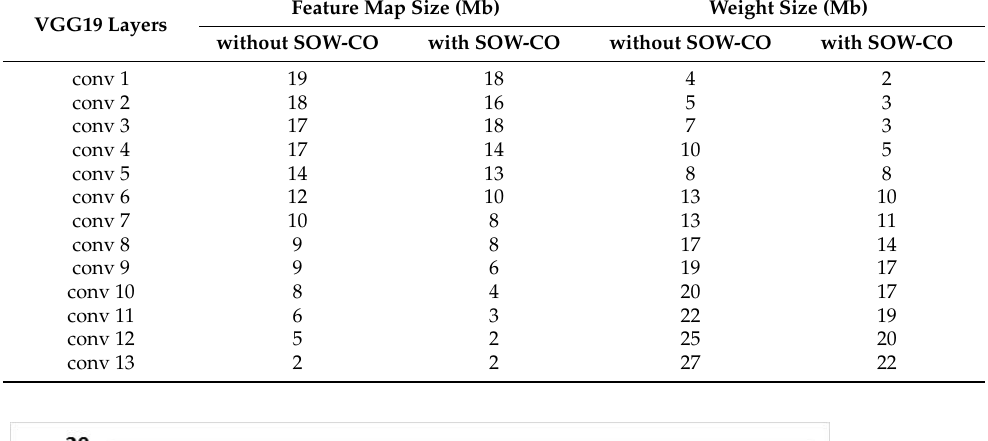
Table 4. Analysis of feature map and weight sizes for VGG19.